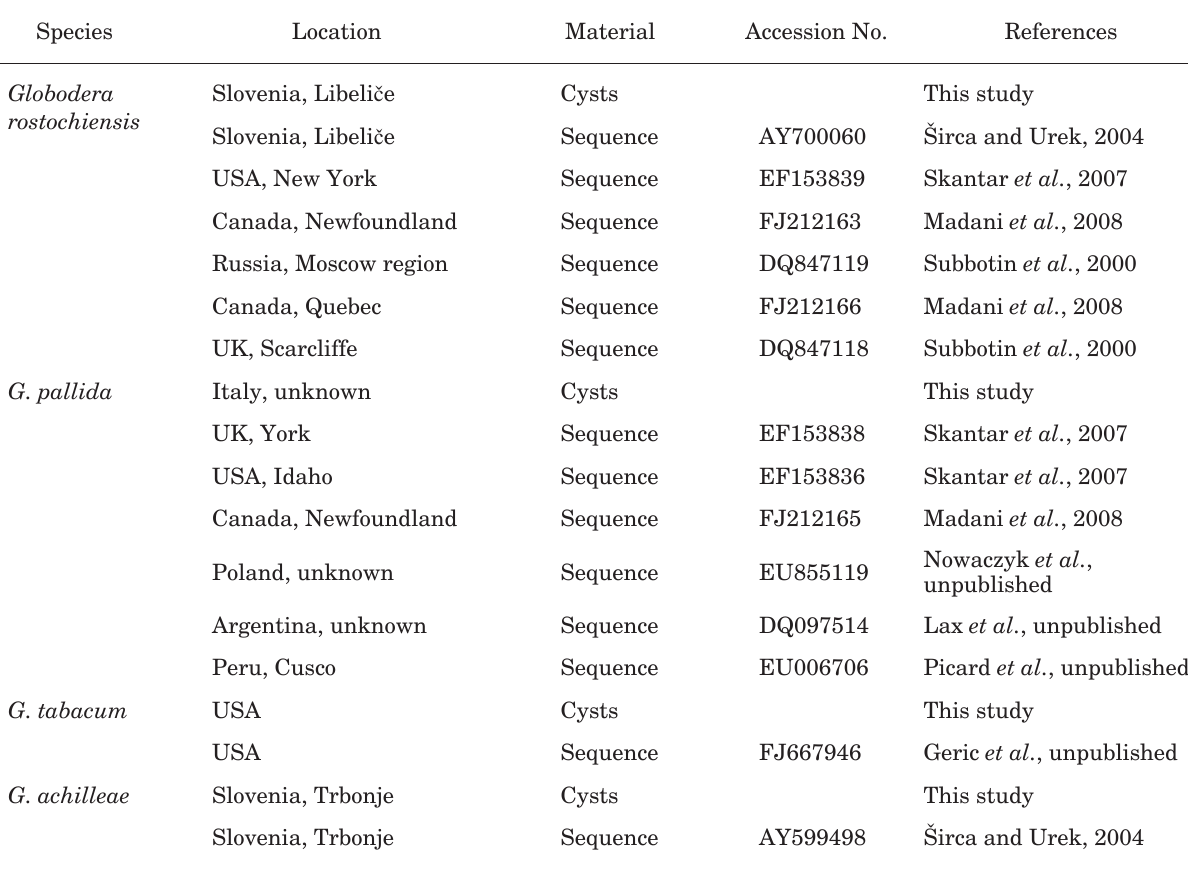
Table 1. List of nematode species, population samples and rDNA sequences used for PCR-RFLP and in situ RFLP